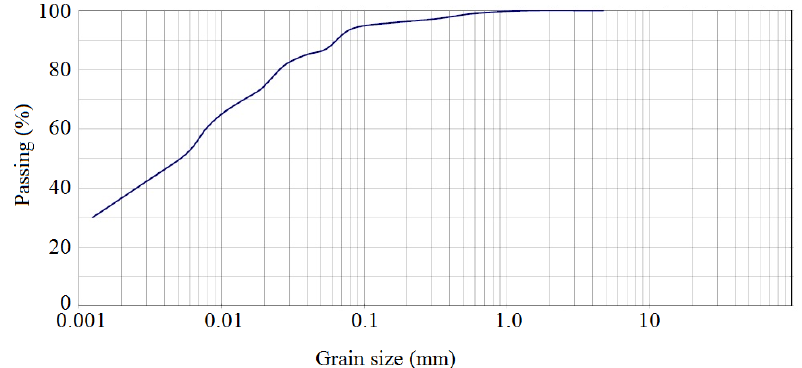
Figure 1. The Tabriz landfill soil’s grain-size analysis result.